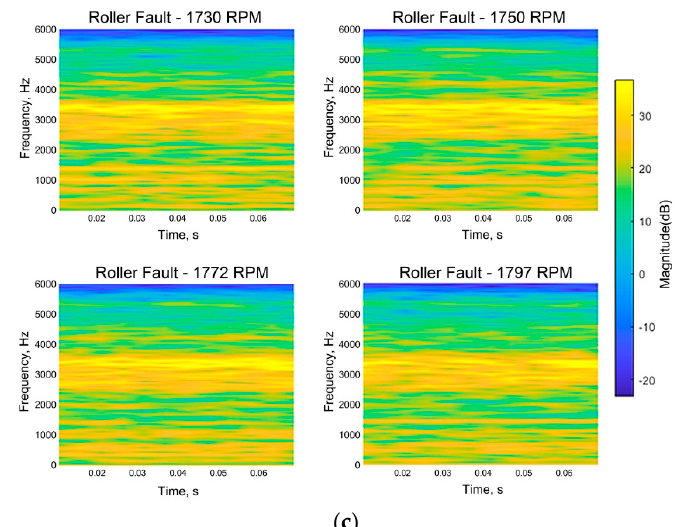
Figure 2. Spectrograms of bearing vibration signals at four different shaft speeds: ( a ) inner race bearing fault, ( b ) outer race bearing fault, and ( c ) roller fault.